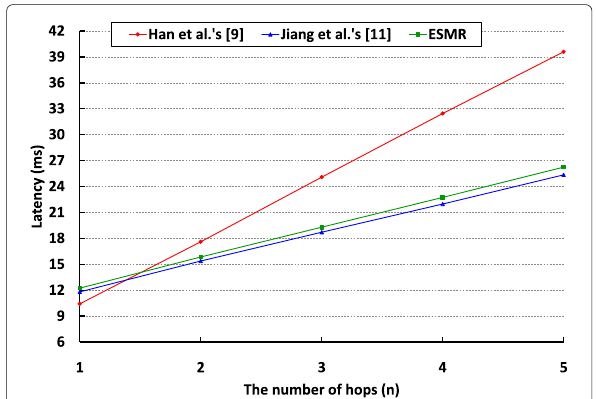
Fig. 10 Packet delivery ratio under DoS attacks based on unconditional